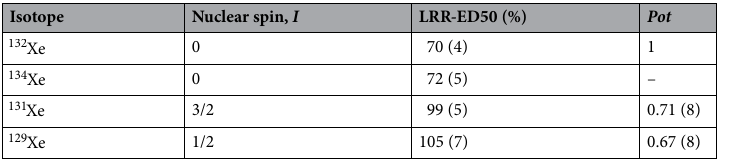
Table 1. Xenon isotopic nuclear spin, LRR-ED50, and Pot values for xenon isotopes Xe. LRR-ED50 values as reported in the work of Li et al. 6